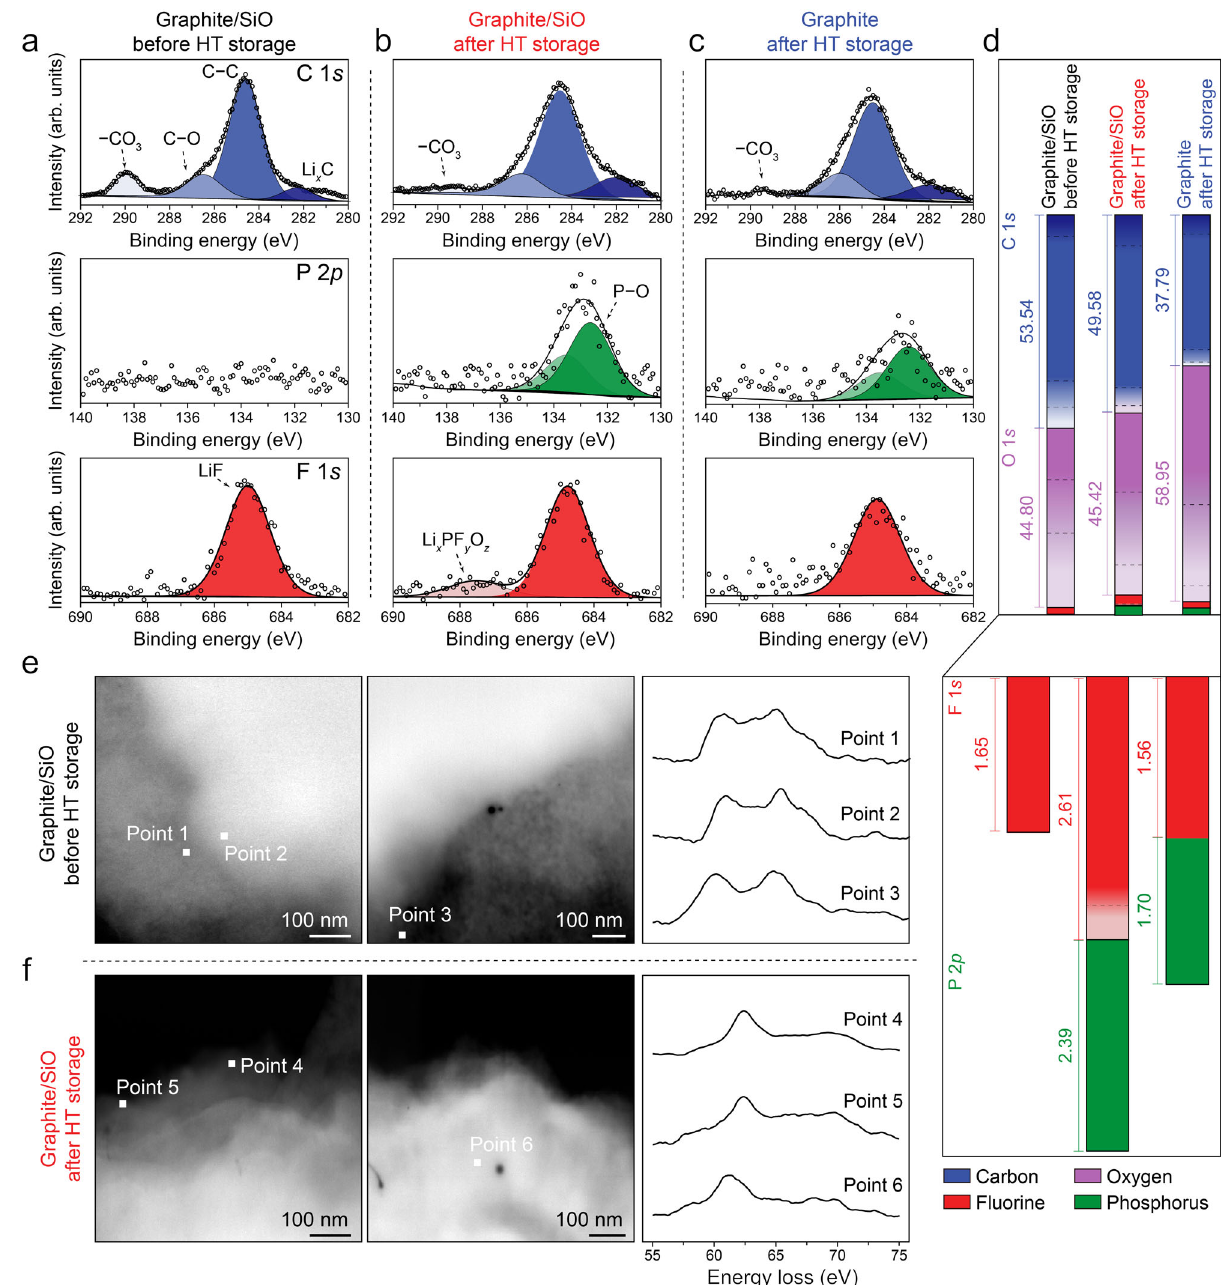
Fig.5|CompositionalchangeontheSEIthroughthermalstorage.a – d XPSC1 s , P 2 p , and F 1 s spectra of a graphite/SiO anode before HT storage, b graphite/SiO and c graphite anode after 4 weeks of HT storage, and d corresponding elemental compositions when the components in four elements (C 1 s , O 1 s , F 1 s , and P 2 p )